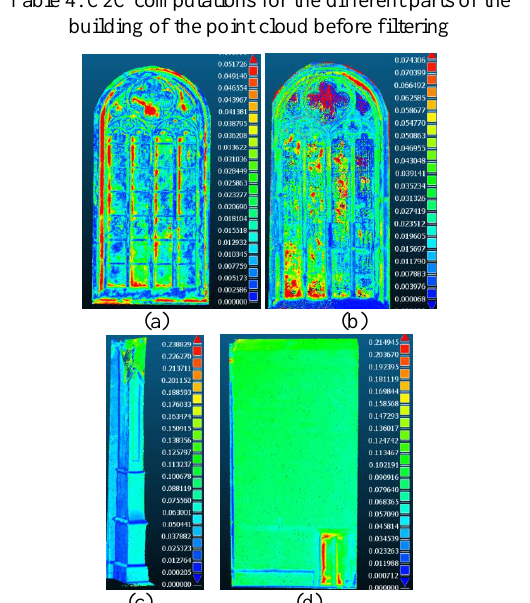
Figure 12. Dense video output before filtering. (a) C2C comparison of window I. (b) C2C comparison of window II. (c) C2C comparison of the column. (d) C2C comparison of the façade.